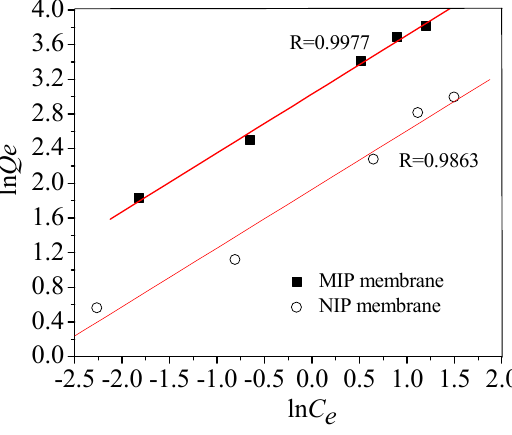
Figure 9. Curves of ln Q e to ln C e of MIP and NIP membrane.